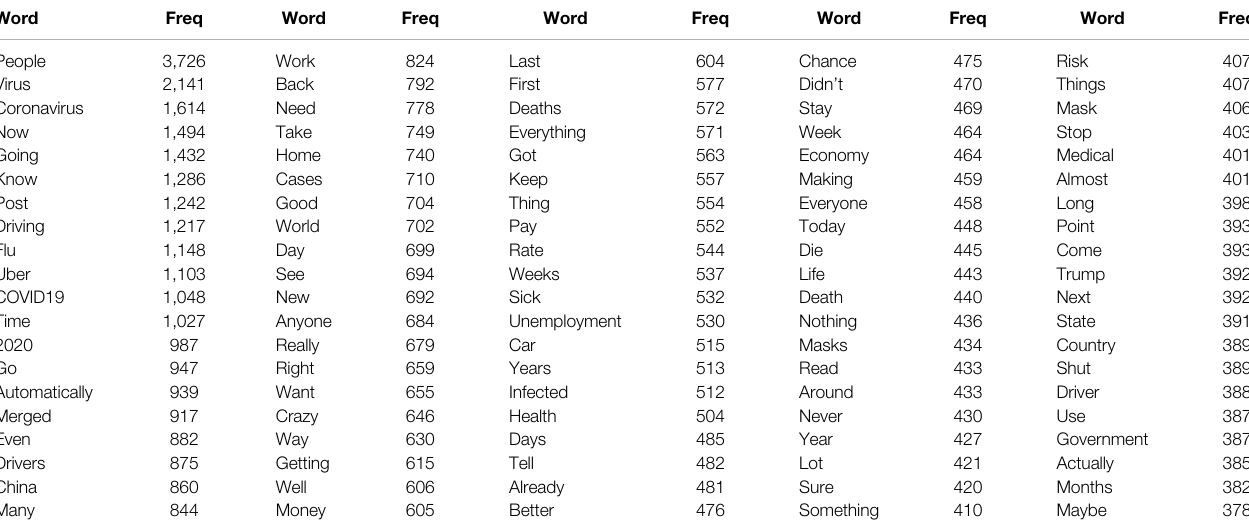
TABLE 1 | Most frequent 100 words of Corona forum. Word Freq Word People